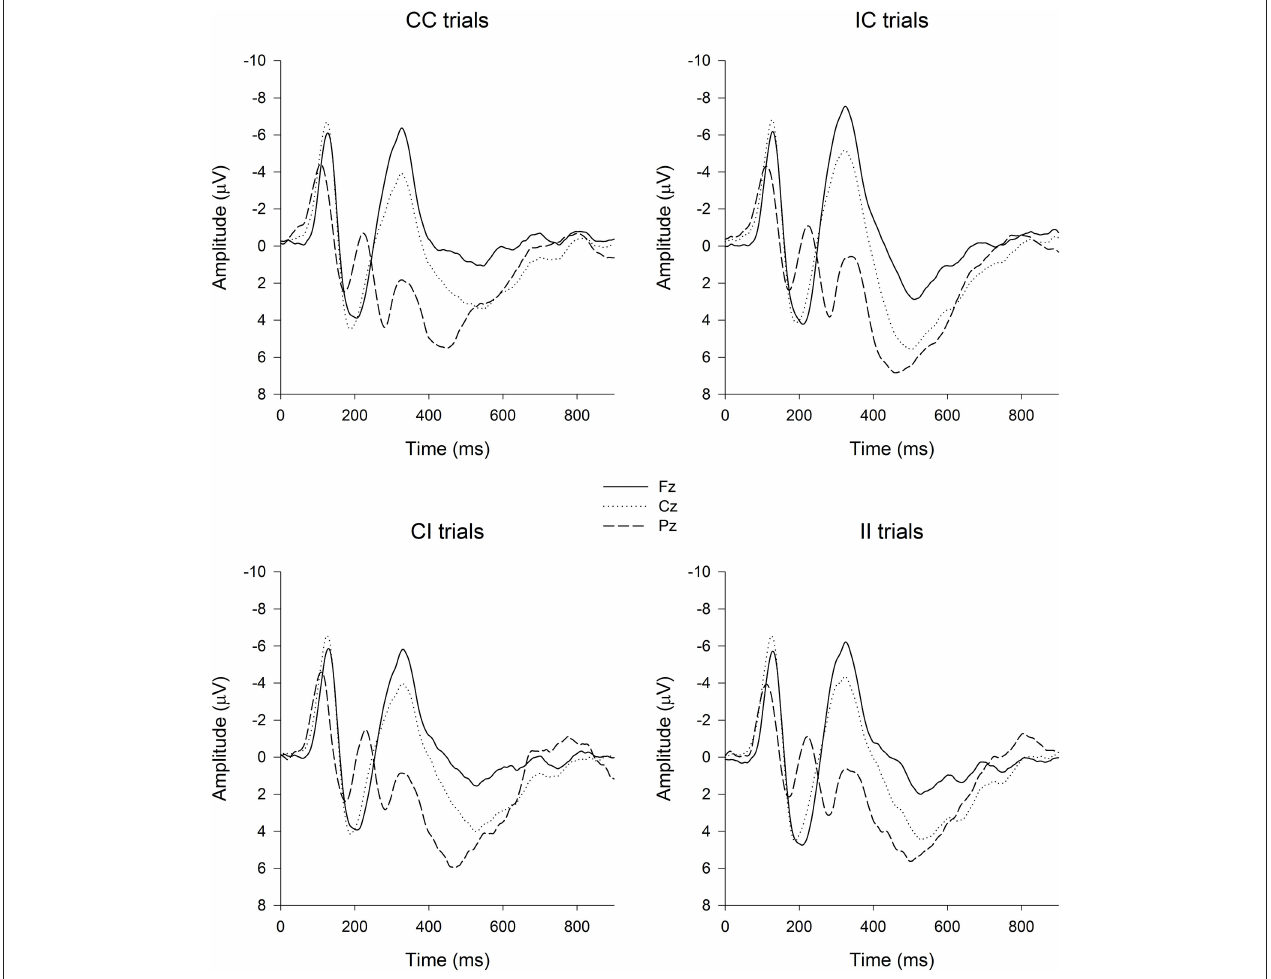
FIGURE 1 | Grand-averaged waveforms in CI, CC, IC, and II, respectively. CC, compatible congruent; CI, compatible incongruent; IC, incompatible congruent; II, incompatible incongruent.